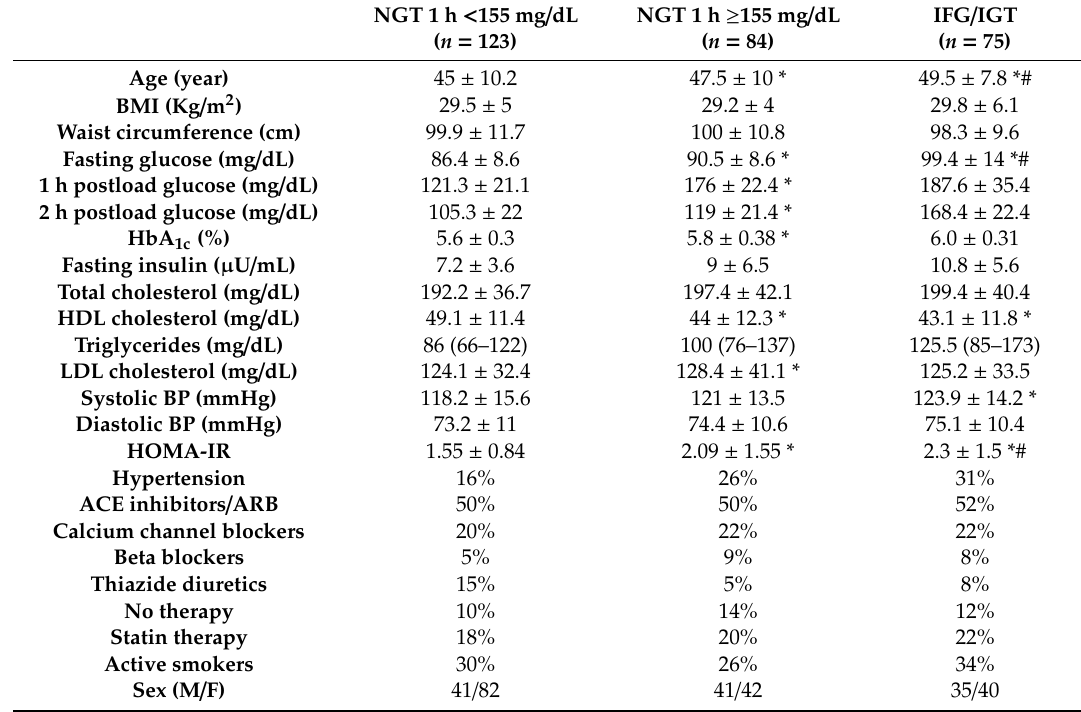
Table 1. Clinical and metabolic characteristics of the study population according to 1 h postload plasma glucose and glucose tolerance.